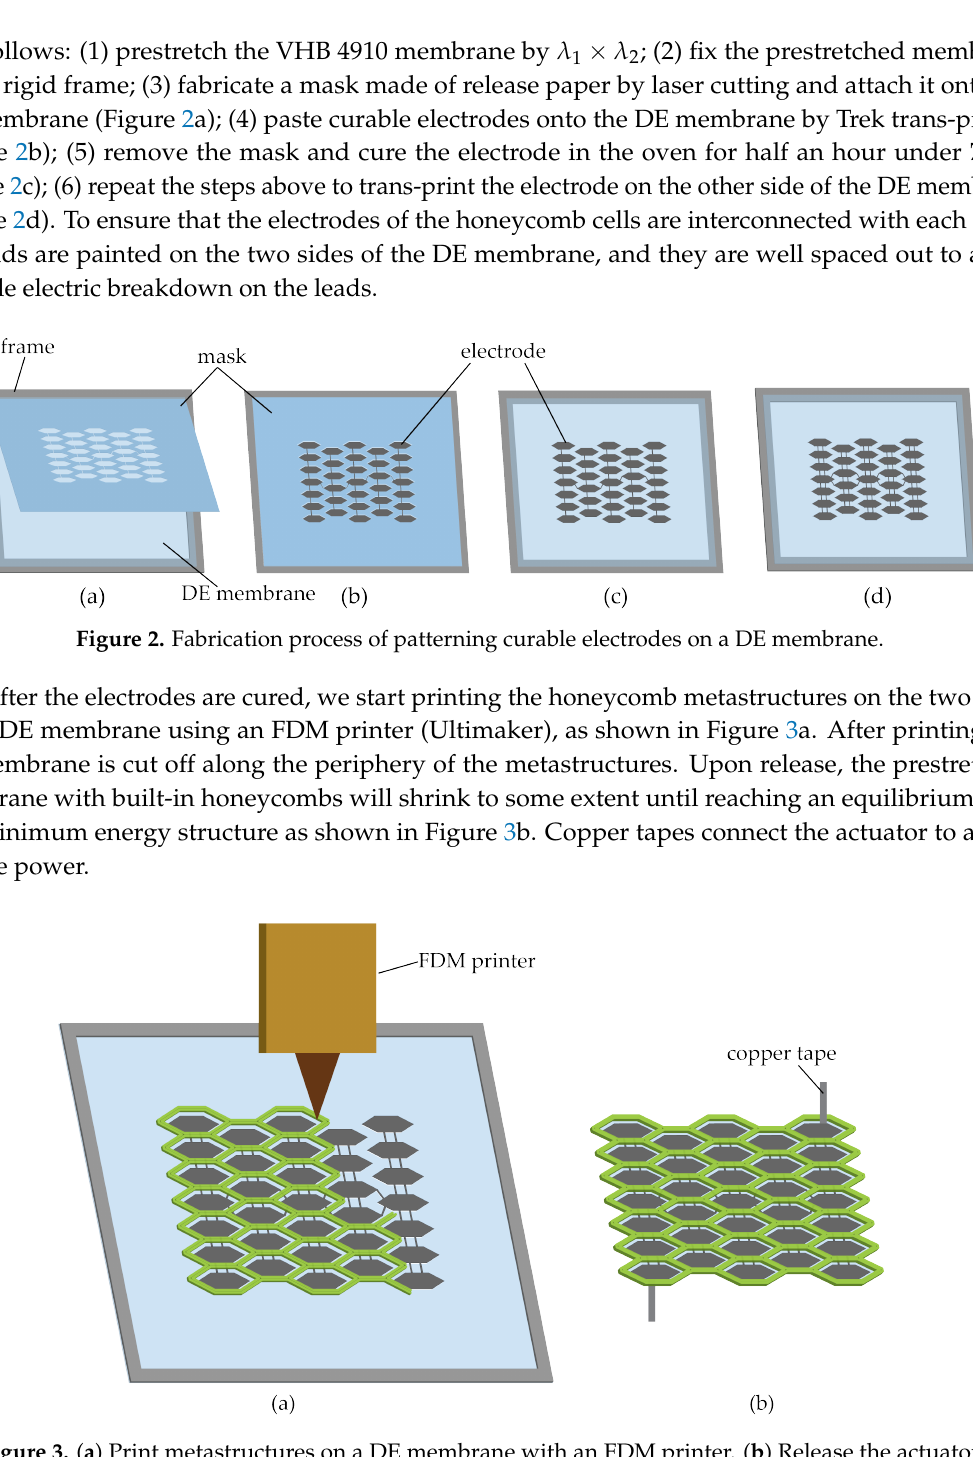
Figure 3. ( a ) Print metastructures on a DE membrane with an FDM printer. ( b ) Release the actuator prototype from the substrate membrane and connect copper tapes to